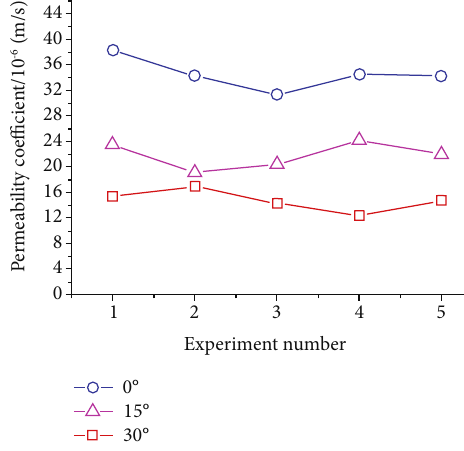
Figure 16: Hydraulic conductivity of initial three-dimensional stress